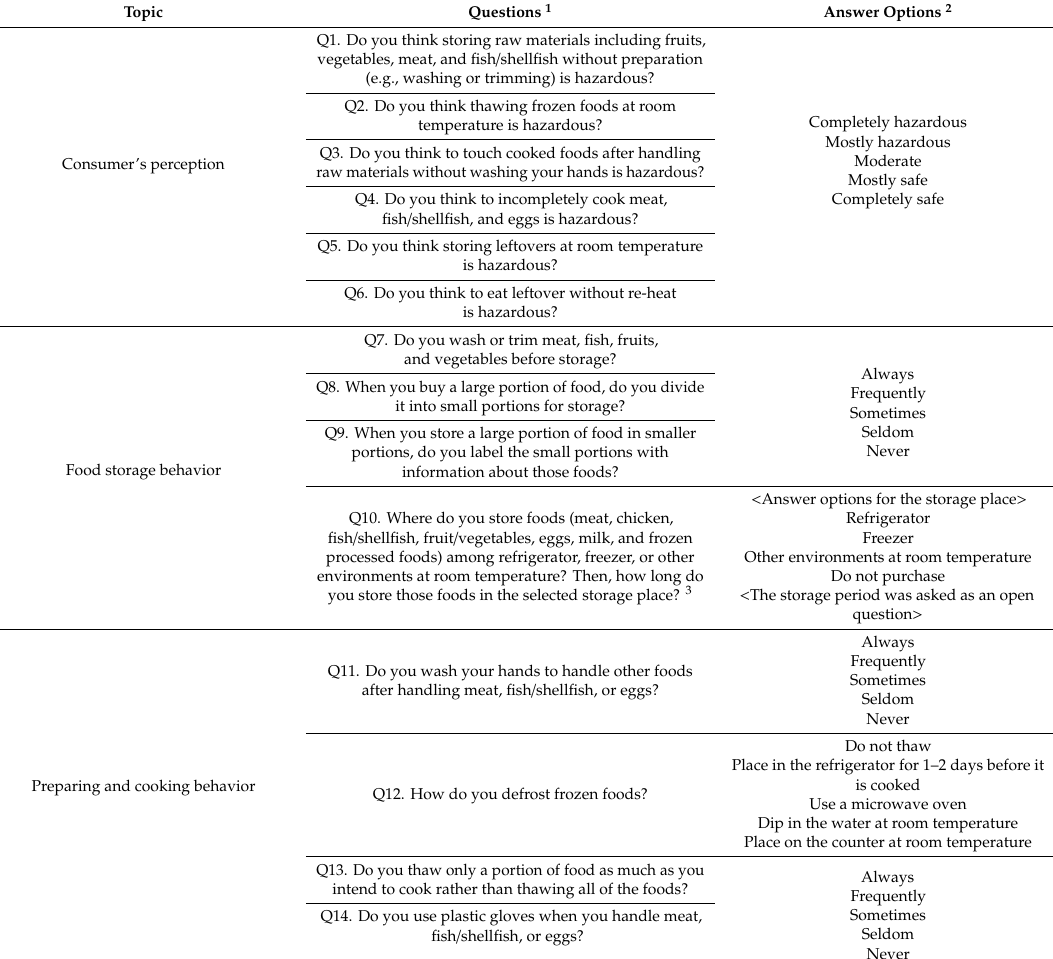
Table 1. Composition of the